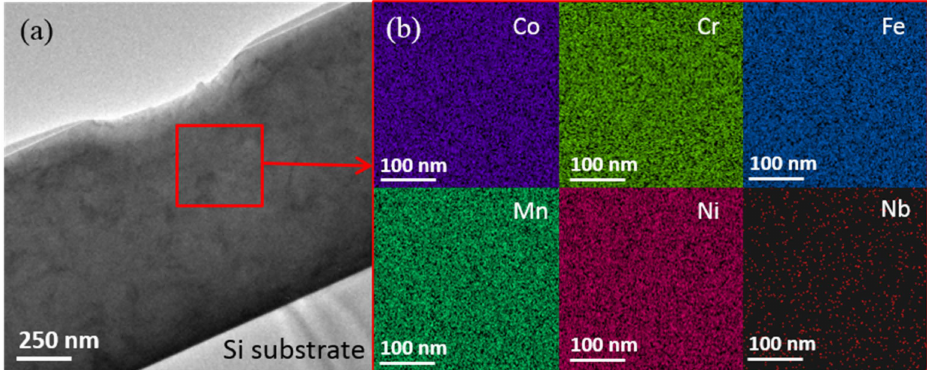
Figure 5. ( a ) The cross-section bright field TEM image of the film with 1.8 at.% Nb and ( b ) elemental distributions of Co, Cr, Fe, Mn, Ni, and Nb in the framed area in ( a ).